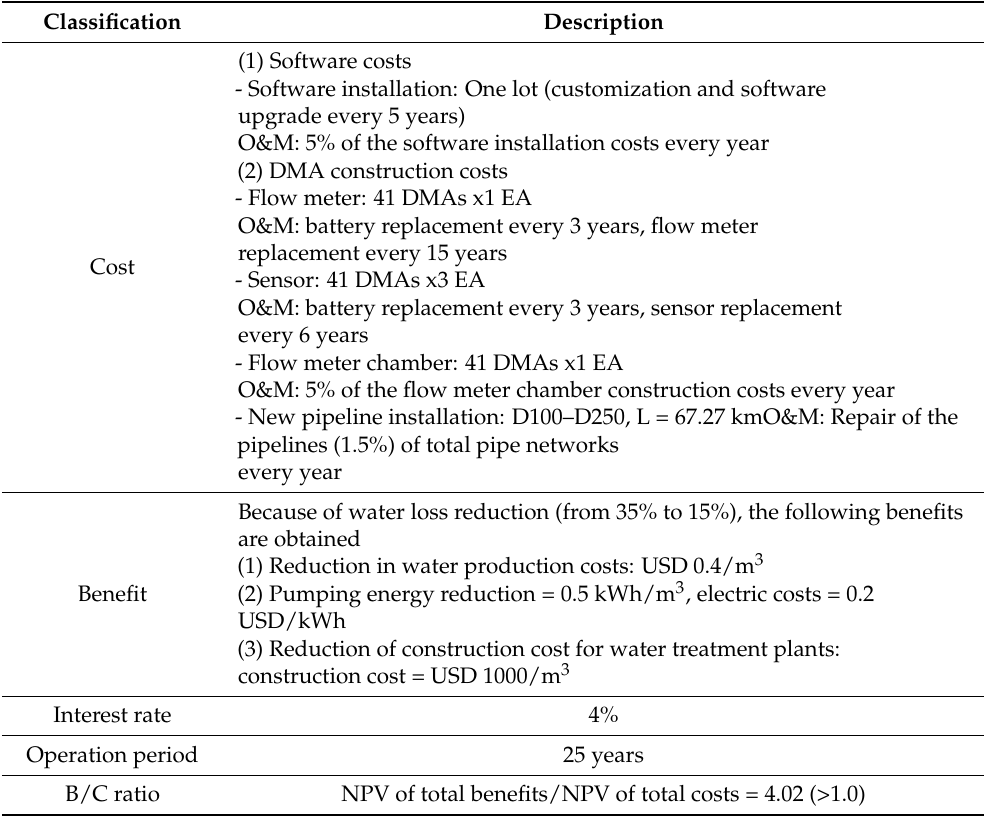
Table 5. Economic